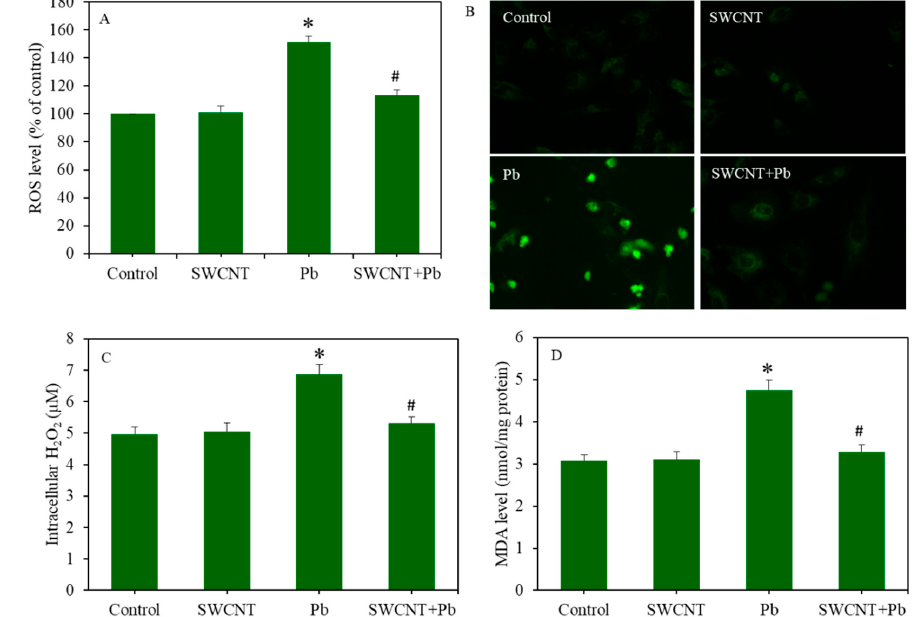
Figure 4. Pro-oxidant levels in A549 cells after exposure to either SWCNTs (10 µg/mL) or Pb (50 µg/mL), or a combination of both (SWCNTs + Pb) for 24 h. ( A ) Quantitative data of intracellular ROS ( B ) Fluorescent microscopic images of intracellular ROS level. ( C ) Intracellular H 2 O 2 level. ( D ) MDA level. Data provided as the mean ± SD of three identical experiments made in three